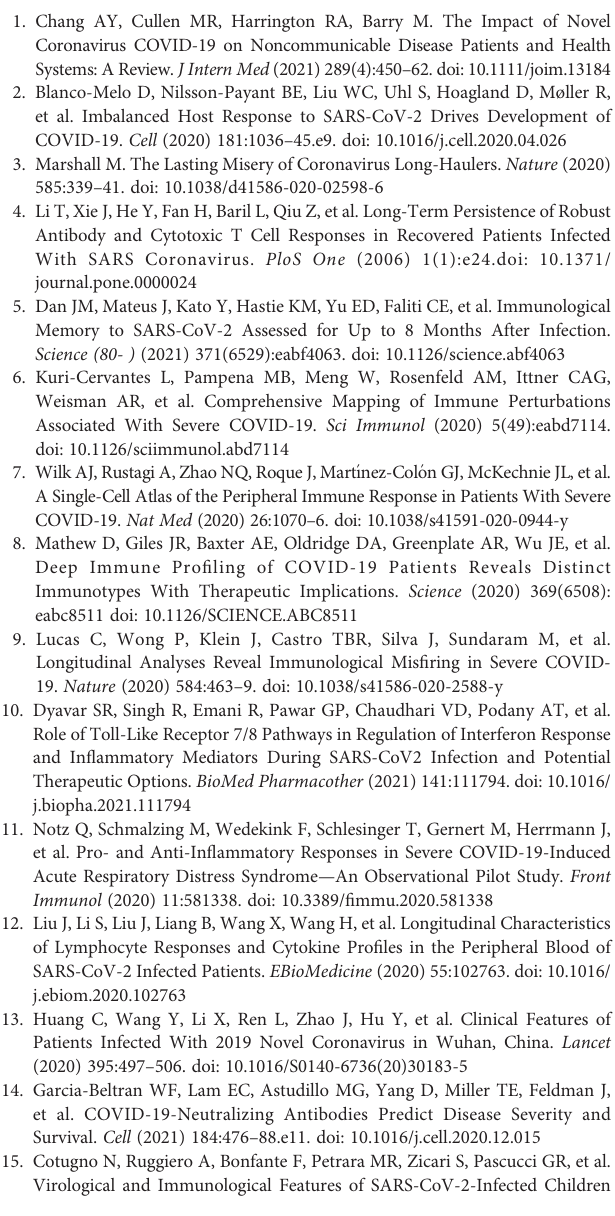
FMO in the presence of the positive control (SEB) and cells in the presence of antibodies and the positive control. Supplementary Figure 2 | Longitudinal evolution of T-cell subsets and antigen speci fi c responses in SARS-CoV-2 Non-Seroconvertors. T-cell markers were assessedintwosamplingtimepoints inNon-Seroconvertors. (A) Gatingstrategyfor differentiation of subsets in CD4+ T cells, (B) and CD8+ T cells. Changes in T-cell subset distributions are represented by pie charts showing CD4+ and CD8+ T-cell subset distribution at sampling timepoint 1 and 2 (TP1 and TP2) (C) and graphs representing the normalized subset values within phenotypes (D) . Differences in Cytokine production and activation induced markers between TP1 and TP2 in response to S and NP are shown in (E) , and PD-1 expression in CD4+ and CD8+ T cells in unstimulated, S- and NP-stimulated cells at TP1 and TP2 are shown in (F) .